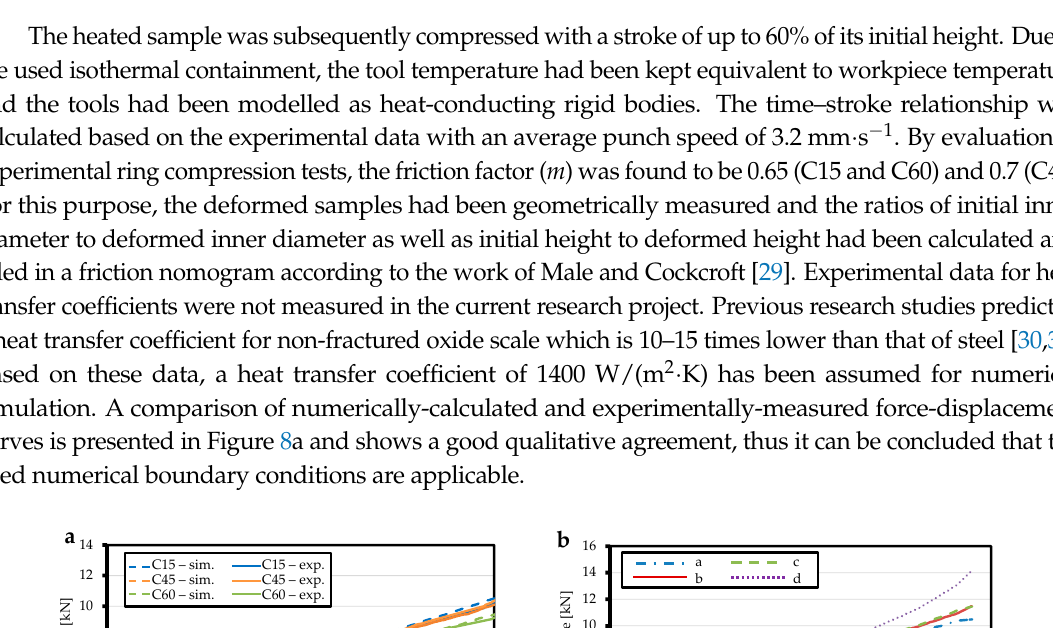
Figure 7. Oxide scale composition depending on oxidation temperature (based on [28]). The mole fractions for an temperature of 1000 °C are indicated by blue lines.